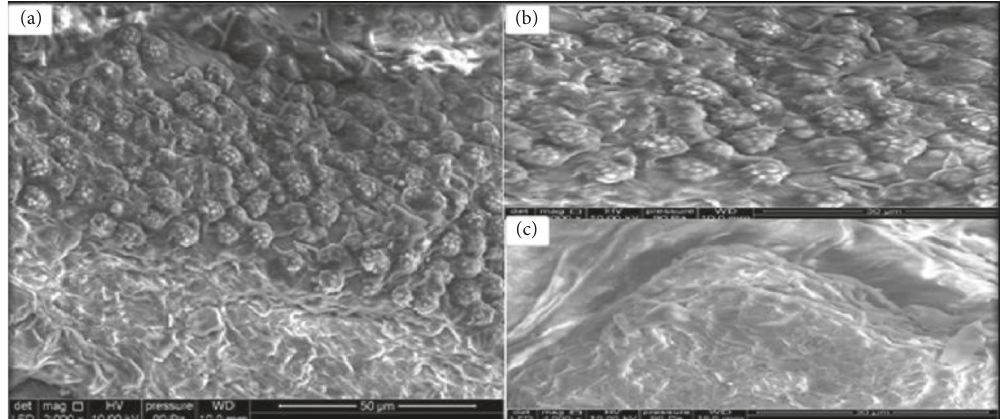
Figure 2: SEM micrographs of PB: magnification (a) × 2000; (b, c) × 4000 (reproduced from Fegousse et al. [38]).